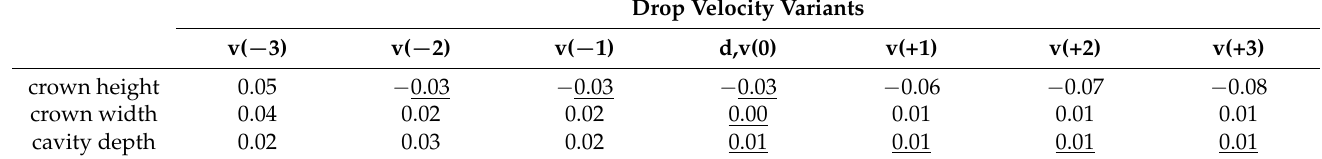
Figure 10. Pictures of the real splash and simulated interfacial profile from variant d,v(0) —white line and the variant d( −3) —red line, at different time intervals: ( a ) 5.4 ms; ( b ) 10.7 ms; ( c ) 16.1 ms; and ( d ) 21.4 ms. Table 3. Relative error calculated as the ratio of the median of the difference between the measured and simulated value to the measured value. Variants for which the absolute value was the smallest are underlined. Drop Size